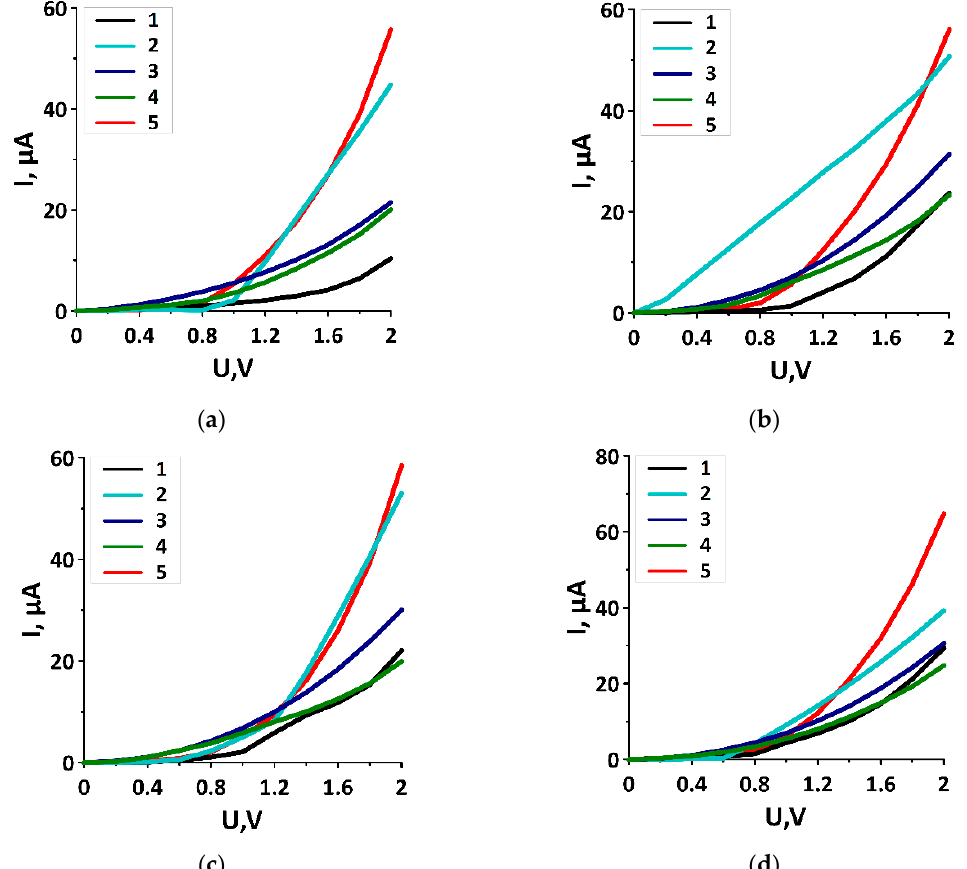
Figure 3. Families of volt-ampere characteristic (VAC) curves of graphene/SWCNT composite films: ( a ) film with SWCNT (10,0) and H1/H2 6/9 hexagons; ( b ) film with SWCNT (12,0) and H1/H2 7/10 hexagons; ( c ) a film with SWCNT (14,0) and H1/H2 8/9 hexagons; ( d ) film with SWCNT (16,0) and H1/H2 9/14 hexagons. The curve with the number “1” denotes the composite film with the corresponding SWCNTs, the curve with the number “2” denotes the SWCNTs from the composite film, the curve with the number “3” denotes the initial SWCNTs, the curve with the number “4” denotes the initial graphene, and the curve with the number “5” denotes the graphene from the composite film.